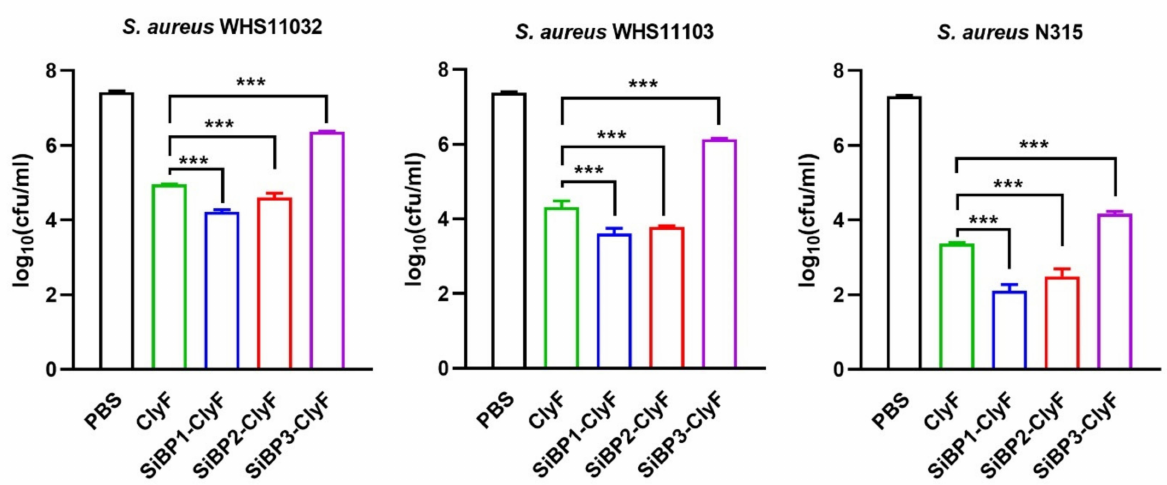
Figure 3. Bactericidal activities of ClyF and its SiBP-fused variants. S. aureus strains WHS11032, WHS11103, and N315 were treated with equal molar concentration (0.7 µ M) of each protein for 1 h at 37 ◦ C, residual number of viable bacteria was determined by plating serial dilutions on LB agar. Data are shown as means ± standard deviations and *** represents p <